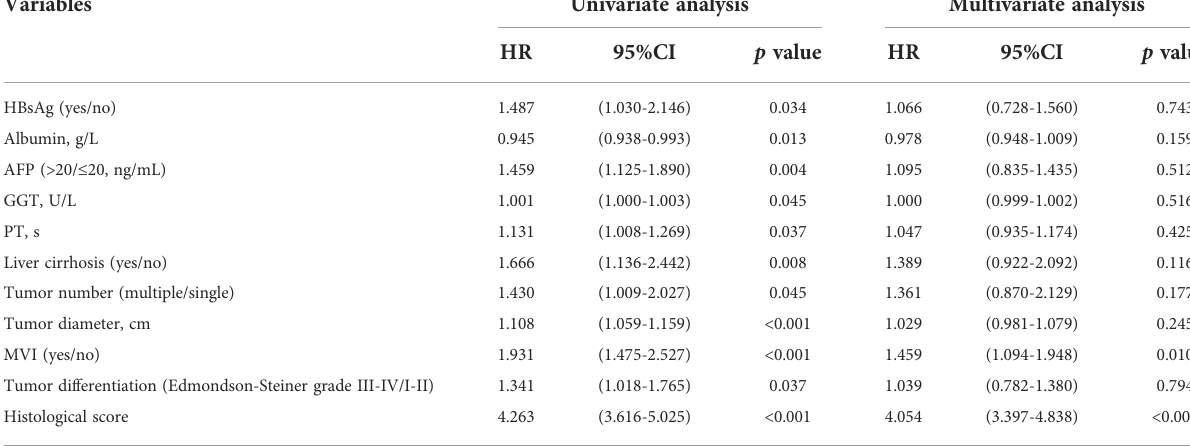
TABLE 2 Cox proportional hazards regression model showing the association of variables with RFS.